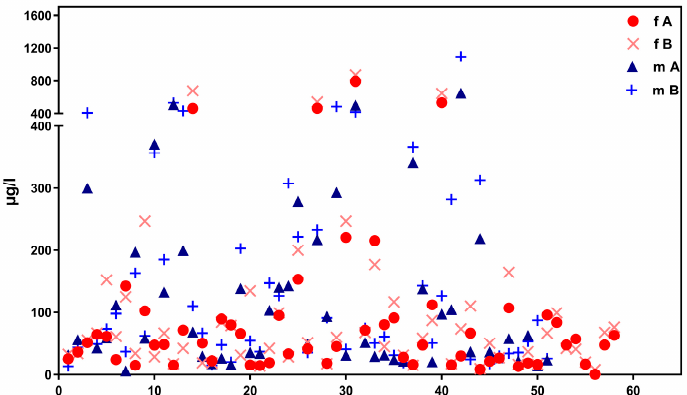
Figure 3. Concentration distribution of ∑ 5OH-MEHP + 5oxo-MEHP (A) und 5cx-MEPP (B) in morning urine of 58 female (f, red symbols) and 51 male (m, blue symbols). Subjects aged between 15 and 30 years from the general population (“Tübingen Survey”). X-axis: urine samples (from female and male participants) in arbitrary order.